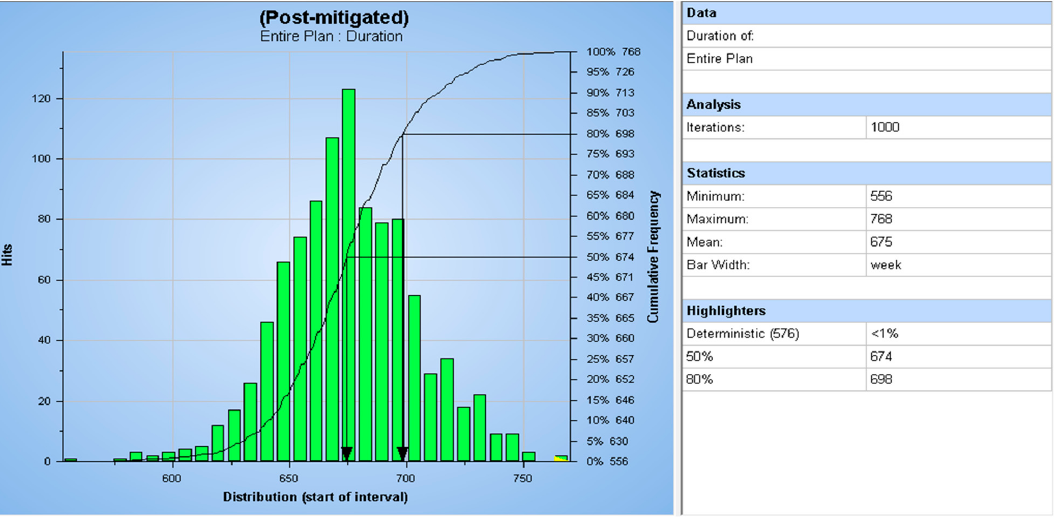
Figure 10. Histogram of the duration of work on the project after the implementation of measures to reduce or limit the impact of risks.